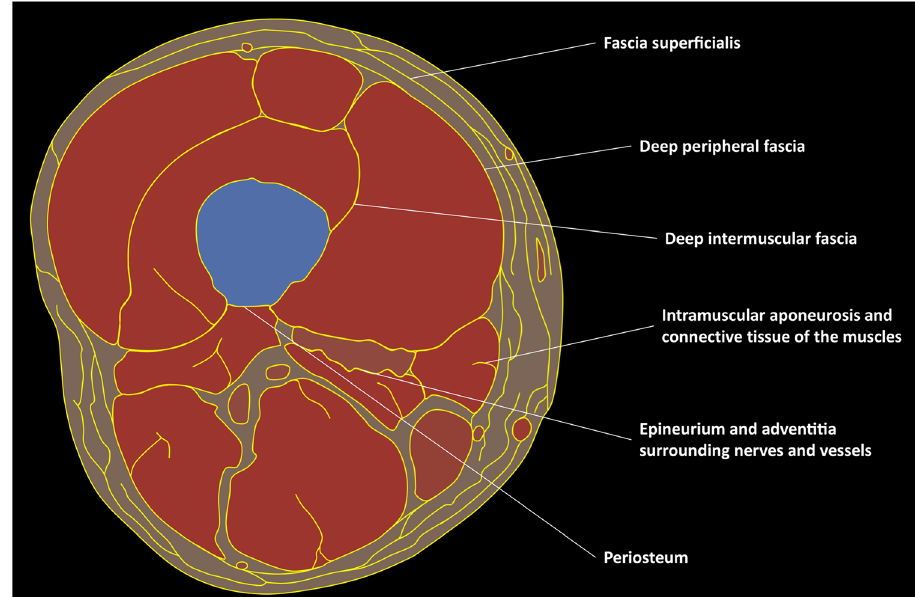
Fig. 2 Schematic drawing of a transverse section of the thigh illustrating its fascial